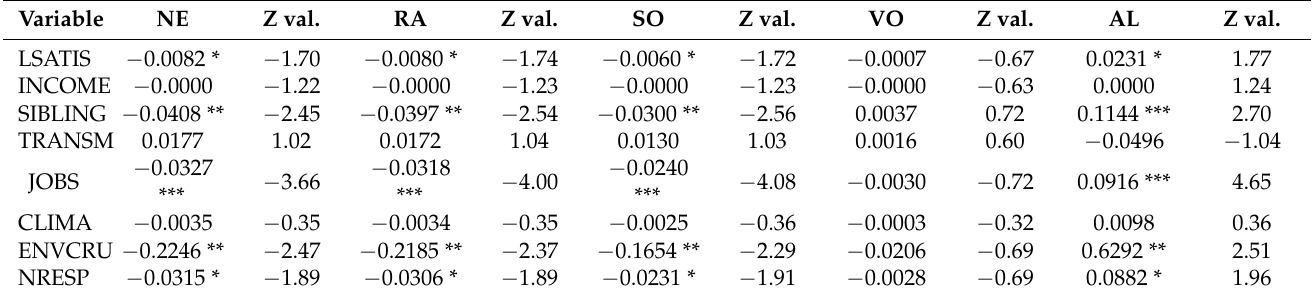
Table 7. Average marginal effects for recycling plastic (low-cost